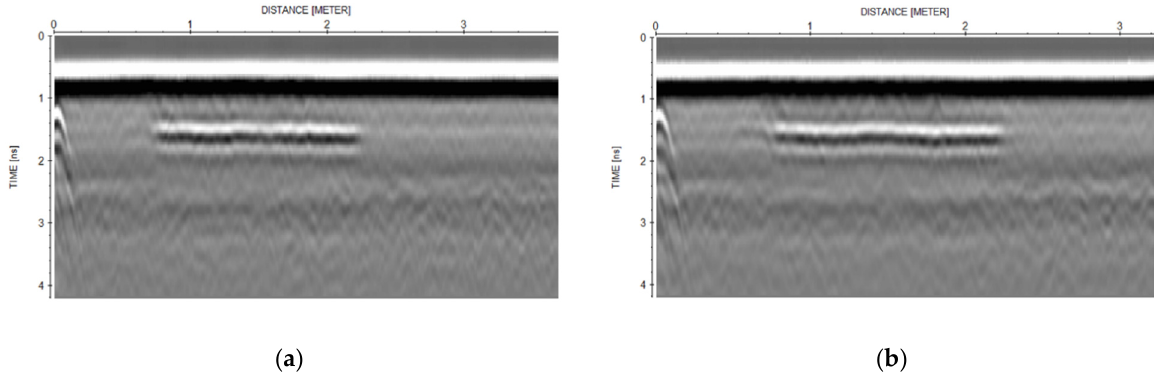
Figure A3. 2.6 GHz impulse B-scans performed on geotextile (I-12) at ( a ) 396 K and ( b ) 720 K loadings.